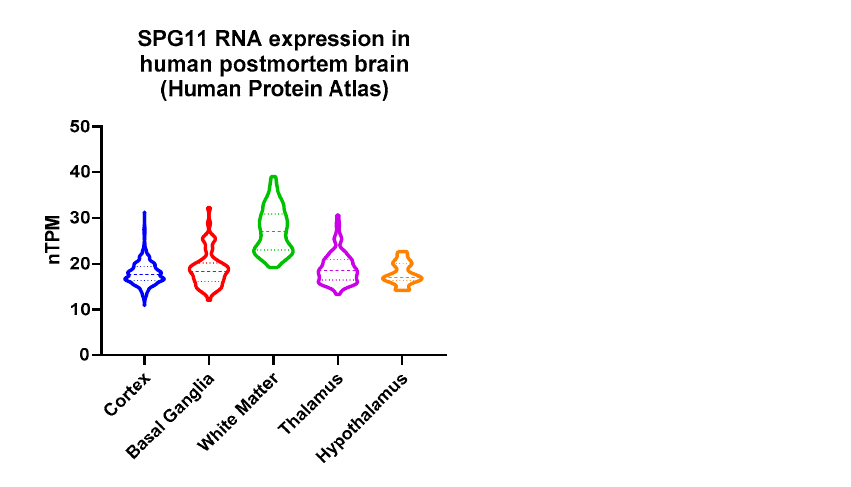
Figure 4. Human brain expression of SPG11 . Normalized transcripts per million (nTPM) derived from the Human Protein Atlas: http://v21.proteinatlas.org access on 3 June 2022[21].